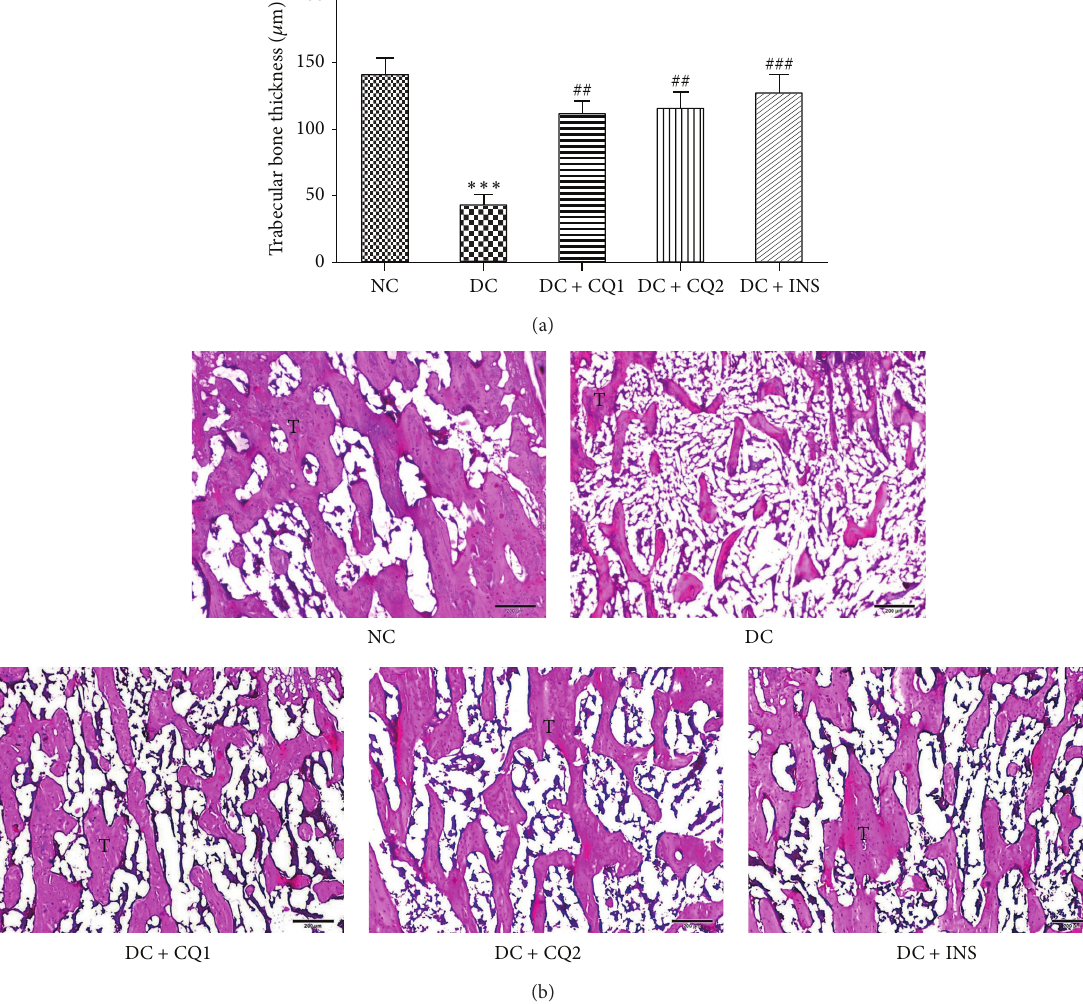
Figure 2: (a) Effect of PECQ on mean thickness of trabecular bone in the metaphyseal region. Thickness of the trabecular bone significantly decreased in diabetic control (DC) rats when compared to normal control (NC) rats. However, treatment with two different doses of PECQ (DC + CQ1 and DC + CQ2) or with insulin (DC + INS) showed a significant increase in the bone thickness, when compared to diabetic nontreated rats. ∗∗∗ 𝑃 < 0.001 when compared to NC group; ### 𝑃 < 0.001 , ## 𝑃 < 0.01 when compared to DC group. (b) Photomicrographs of the trabecular bone in metaphyseal region. Thinner, disrupted, and reduced number of trabeculae were observed in the diabetic control group (DC) when compared to the normal control group (NC). Further treatment with two doses of PECQ (DC + CQ1, DC + CQ2) and insulin (DC + INS) improved the trabecular bone growth. T: trabecular bone; H and E staining, scale bar: 200 𝜇 m.